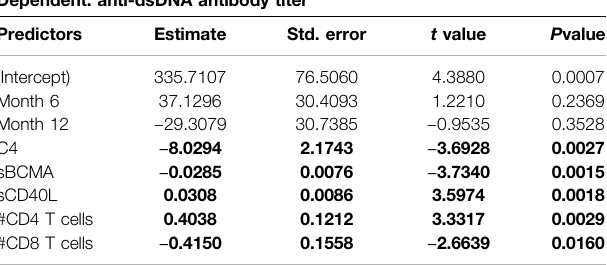
TABLE 5 | Results of robust mixed linear regression model for predictors of anti- dsDNA antibody titer. Individual Patient ID was included as random effect in the model. Predictor values were measured at all timepoints.